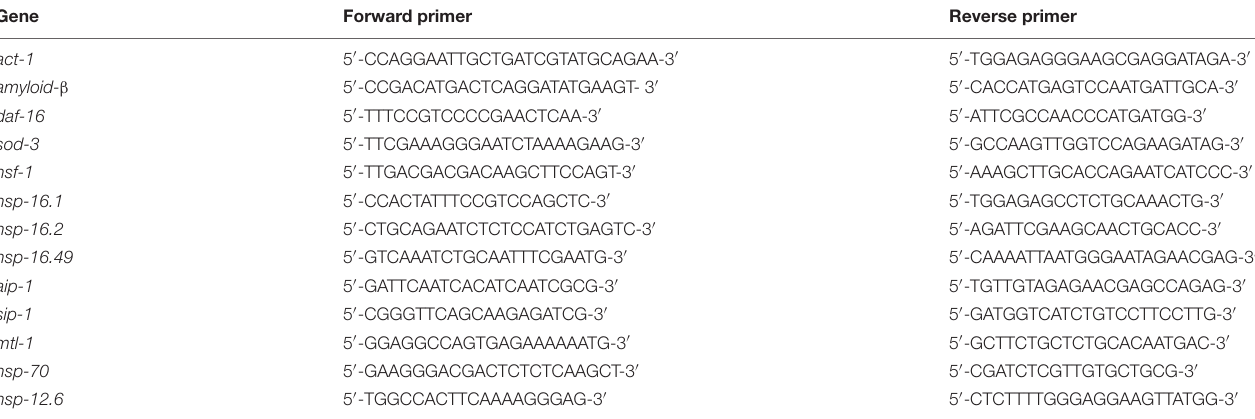
TABLE 1 | Lists of primers of target